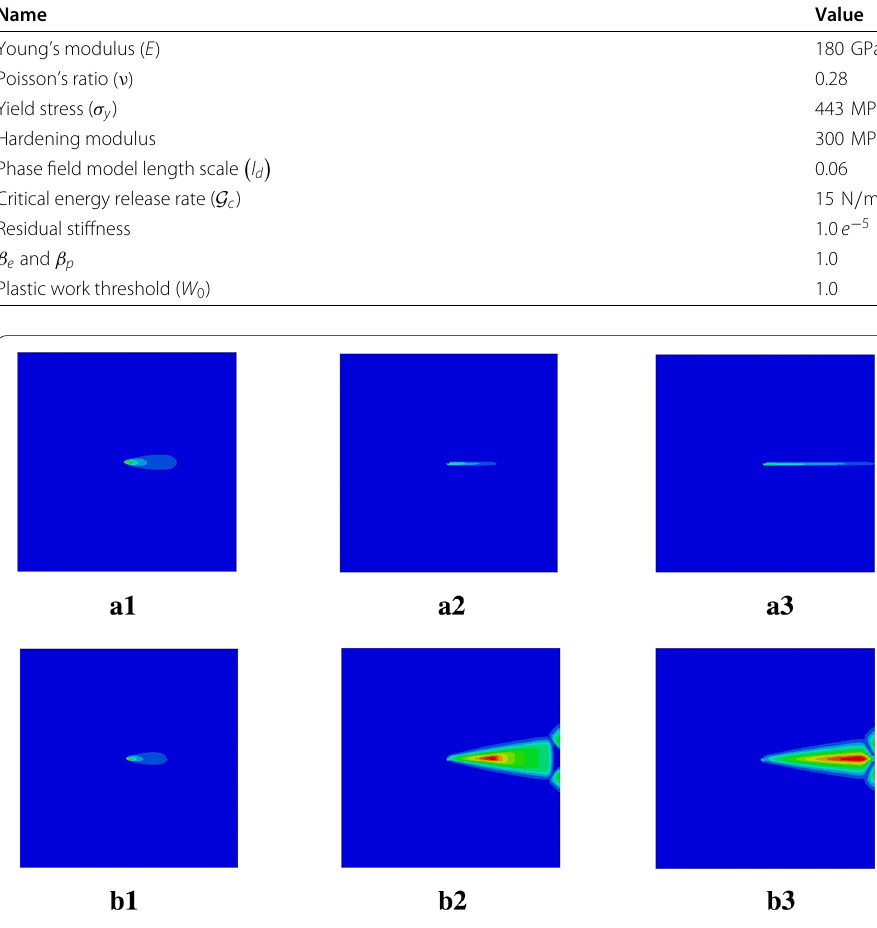
Fig. 10 Contour plots of equivalent plastic strain a (1–3) and the regularized crack b (1–3) at u 1 = 0 . 1mm,